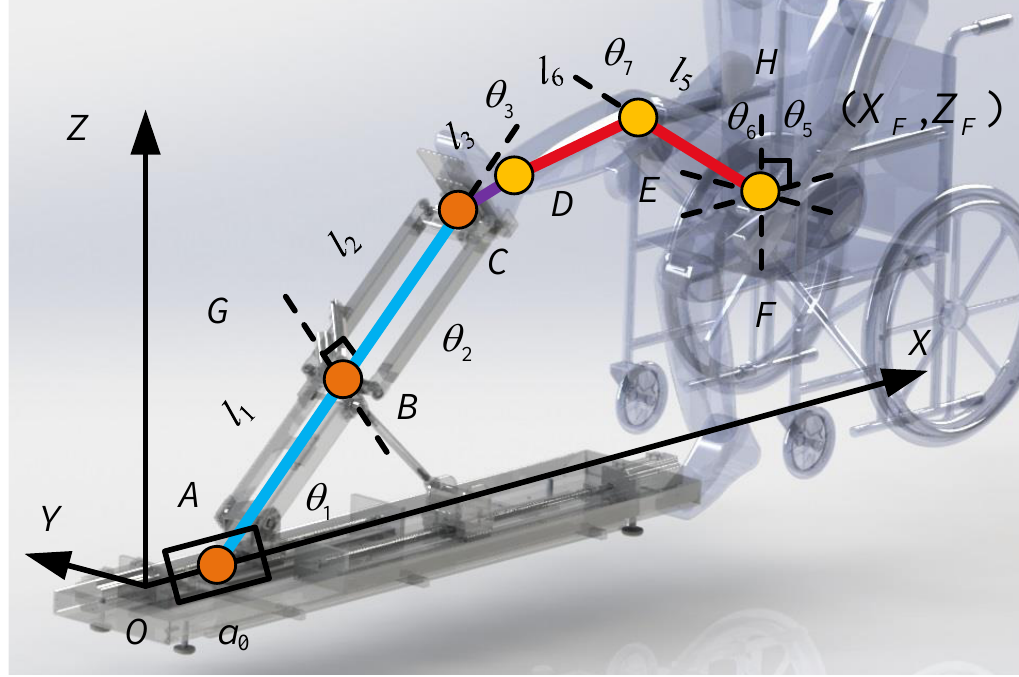
Figure 4. Human-robot hybrid kinematic model.